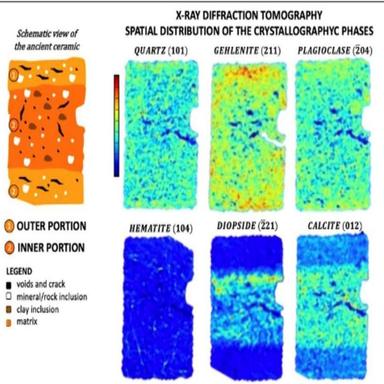
XRDCT reconstruction images showing the spatial distribution of the main phases within the ancient ceramic. For clarity, a schematic drawing of the ceramic with a clear distinction between the outer and inner portions as observed during OM is also reported (sample size: 2 × 4 mm horizontal x vertical).